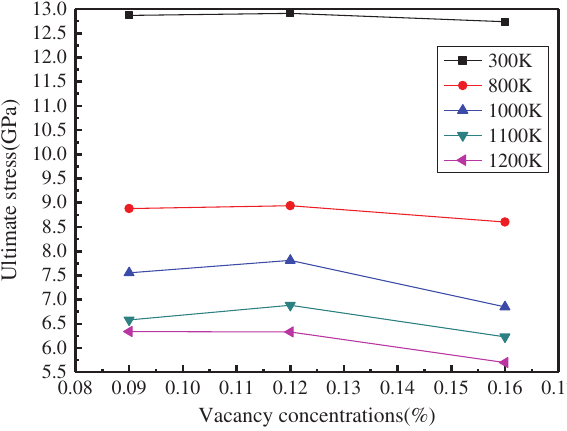
Figure 5: Ultimate stress curves at different temperatures and